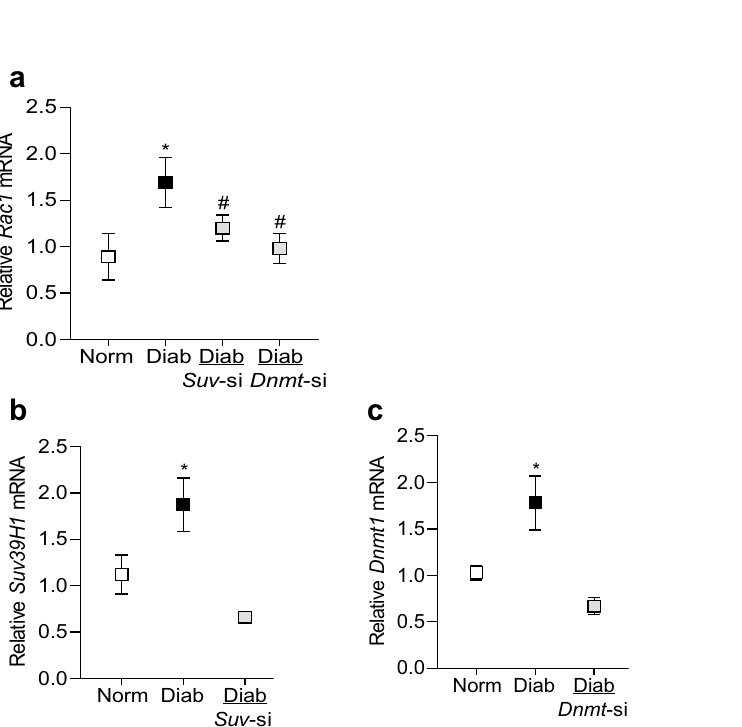
Figure 5. Effect of diabetes on Rac1 promoter histone modifications in mouse retinal microvessels. Retinal microvessels from Stz-induced diabetic mice (Diab) and their age-matched normal mice (Norm) were analyzed for ( a ) H3K9me3, ( b ) H3K9me2 and ( c ) Suv39H1 at Rac1 promoter by ChIP technique. ( d ) 5hmC levels at Rac1 promoter were quantified by immunoprecipitating 5hmC in the genomic DNA. Normal rabbit IgG (^) was used as an antibody control. Each measurement was made in duplicate in 5–7 mice in each group. * p < 0.05 compared to normal.